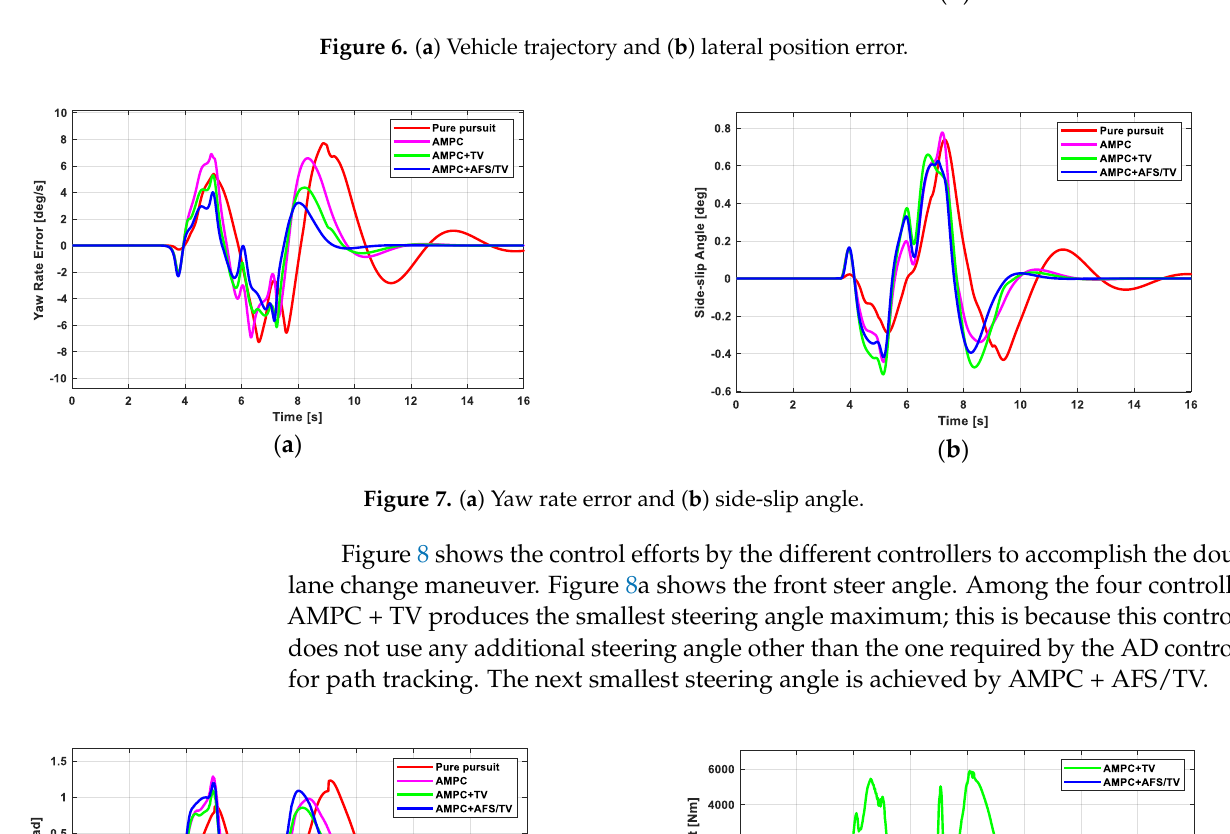
Figure 7. ( a ) Yaw rate error and ( b ) side-slip angle.